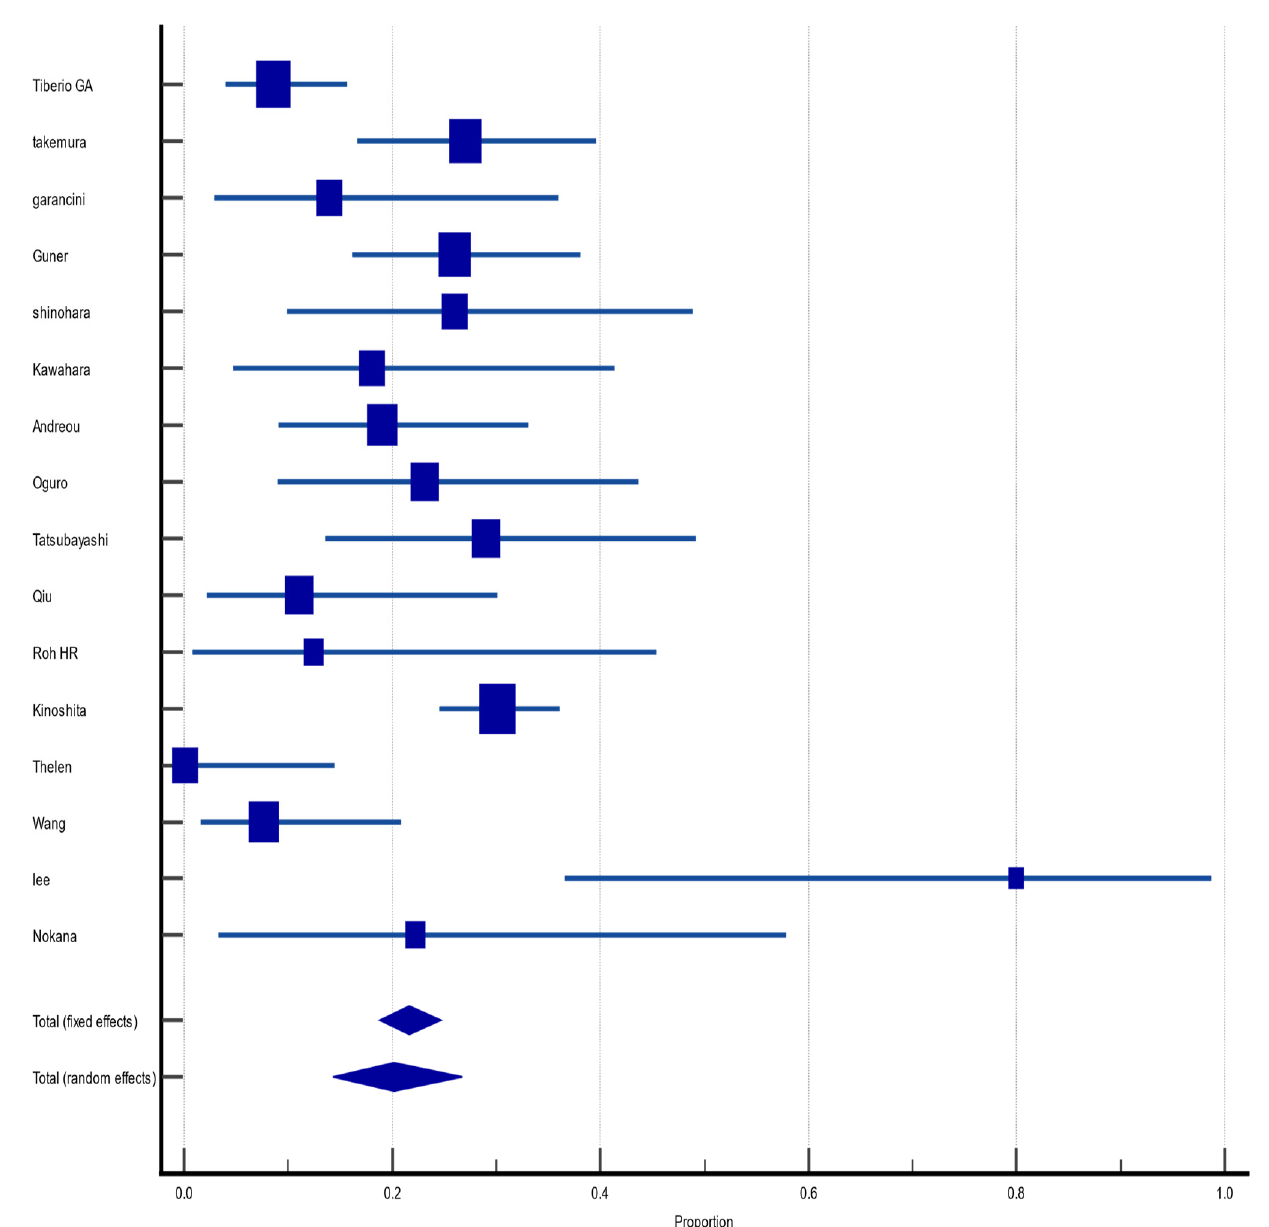
Figure 7. Forest plot of disease-free survival at 5 years after hepatectomy for gastric cancer liver metastasis (GCLM). Description of the proportion and confidence intervals at 95% in the studies that reported 5-year disease-free survival.